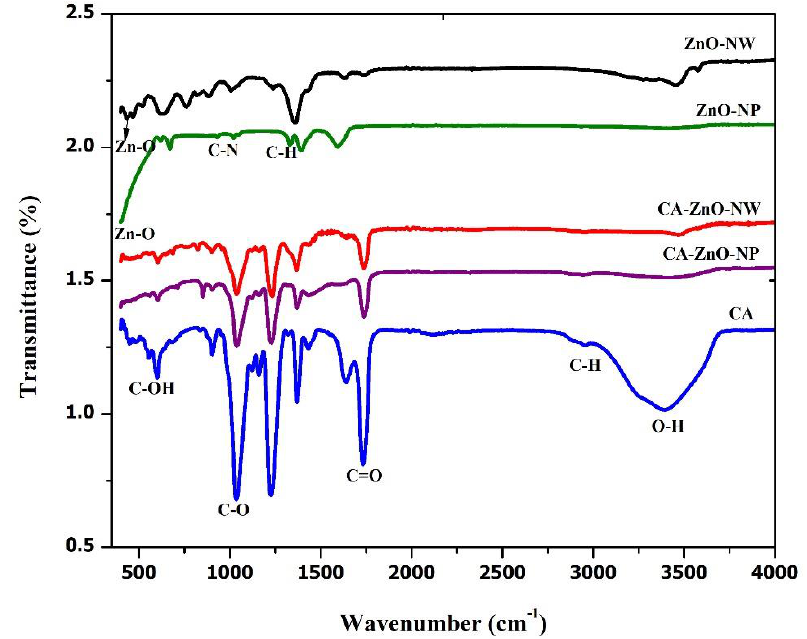
Figure 4. FTIR spectra of the pristine CA membrane, the CA-ZnO-NP membrane, and the CA-ZnO-NW membrane.